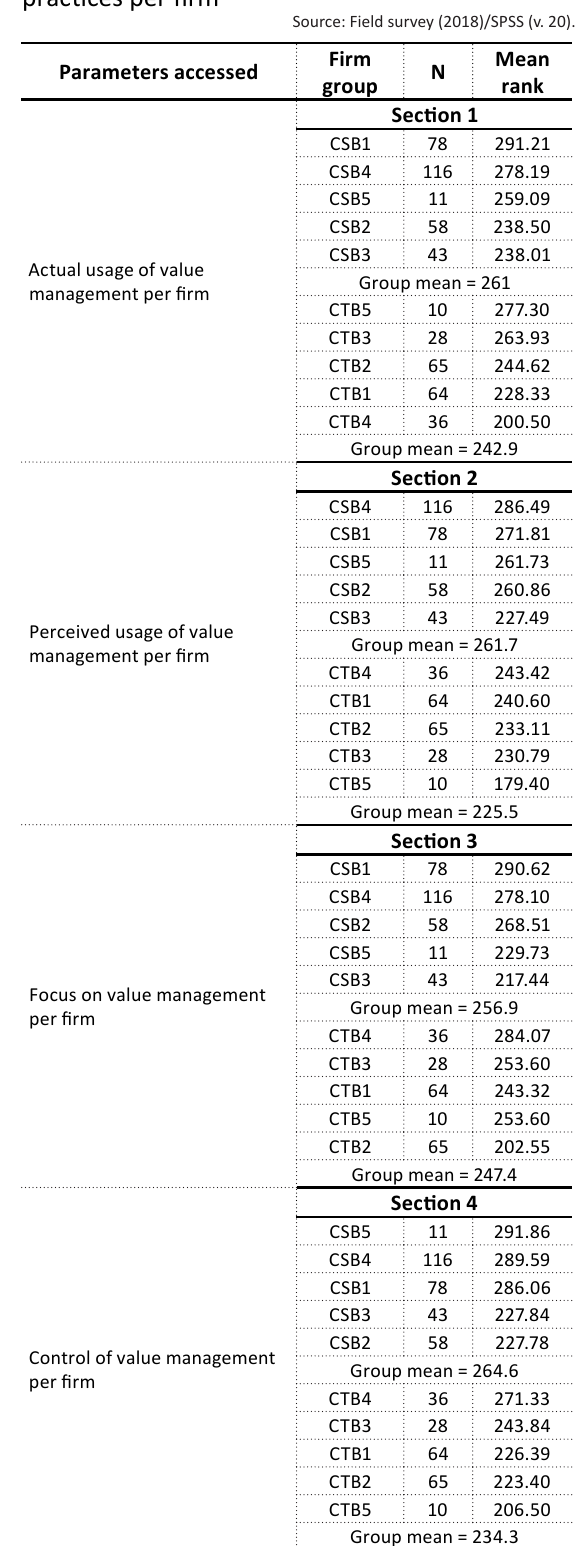
Table 2. Mean rank of value management practices per firm